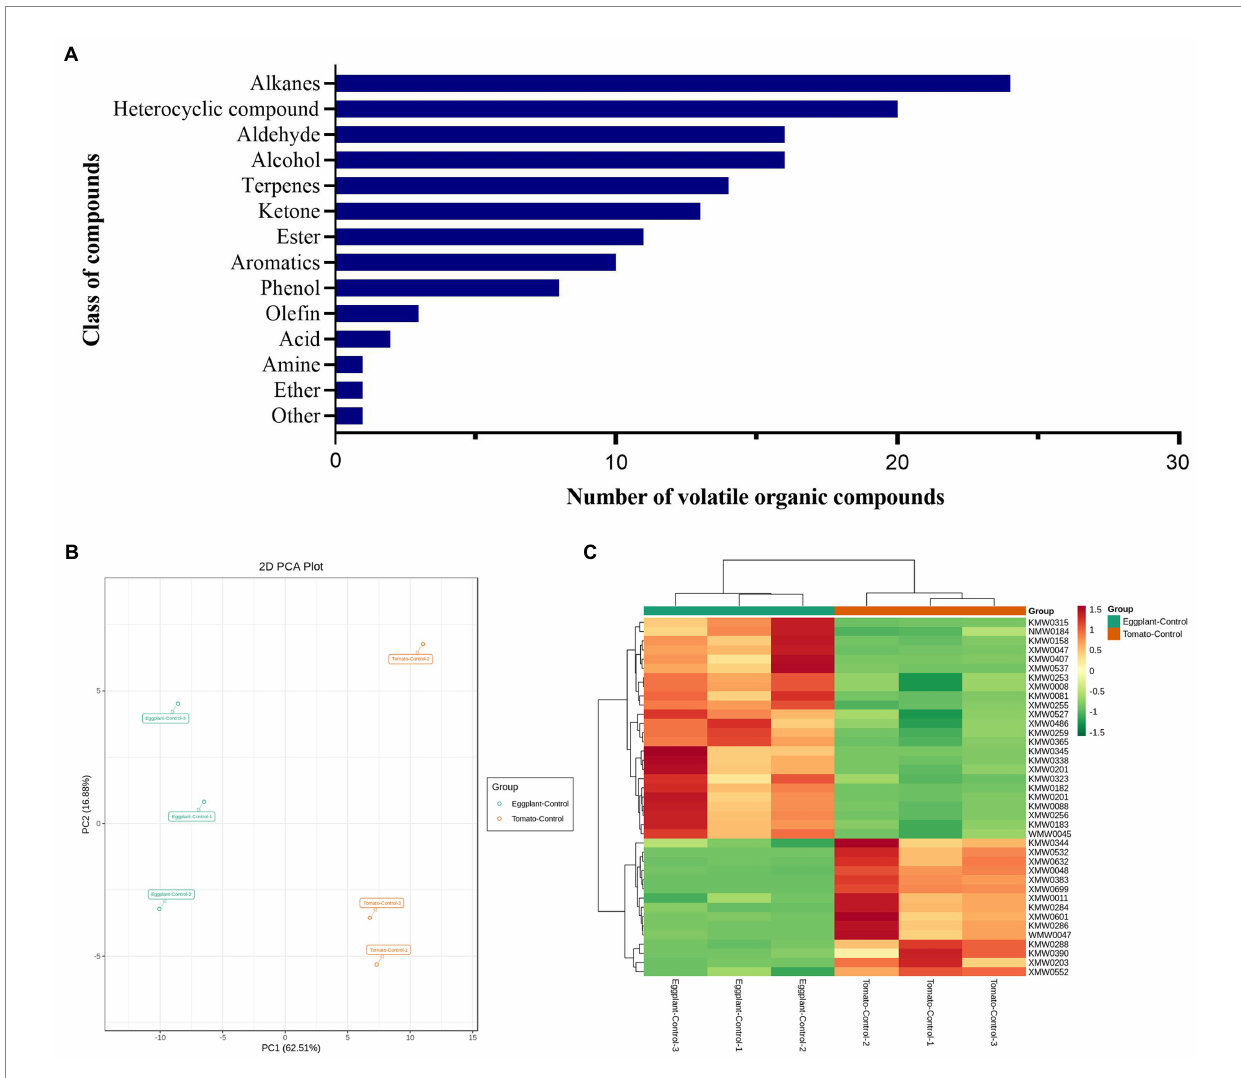
FIGURE 1 (A) Classes of volatile organic compounds identified of tomato and eggplant. (B) Principal component analysis (PCA) of differentially accumulated VOCs identified from tomato and eggplant leaves by headspace solid-phase microextraction (HS-SPME). (C) Heatmap clustering of 39 differentially accumulated VOCs identified from tomato and eggplant